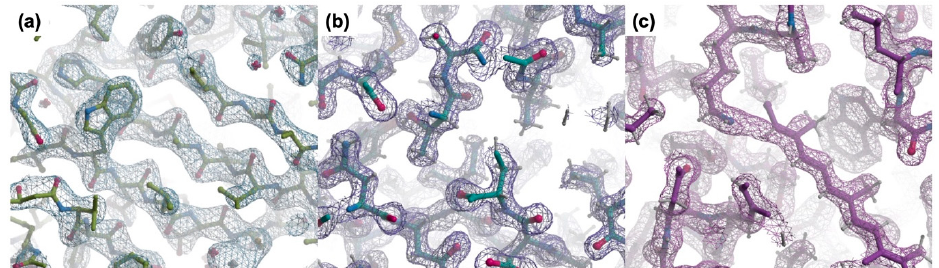
Figure 3. Refined protein structures and electron density maps using merged intensity data from the EM-detwin program. ( a ) the IN-CCD structure, ( b ) the BLAC structure and ( c ) the bacteriorhodopsin (BR) structure. The 2Fo-mFc maps were shown at σ = 2.0.